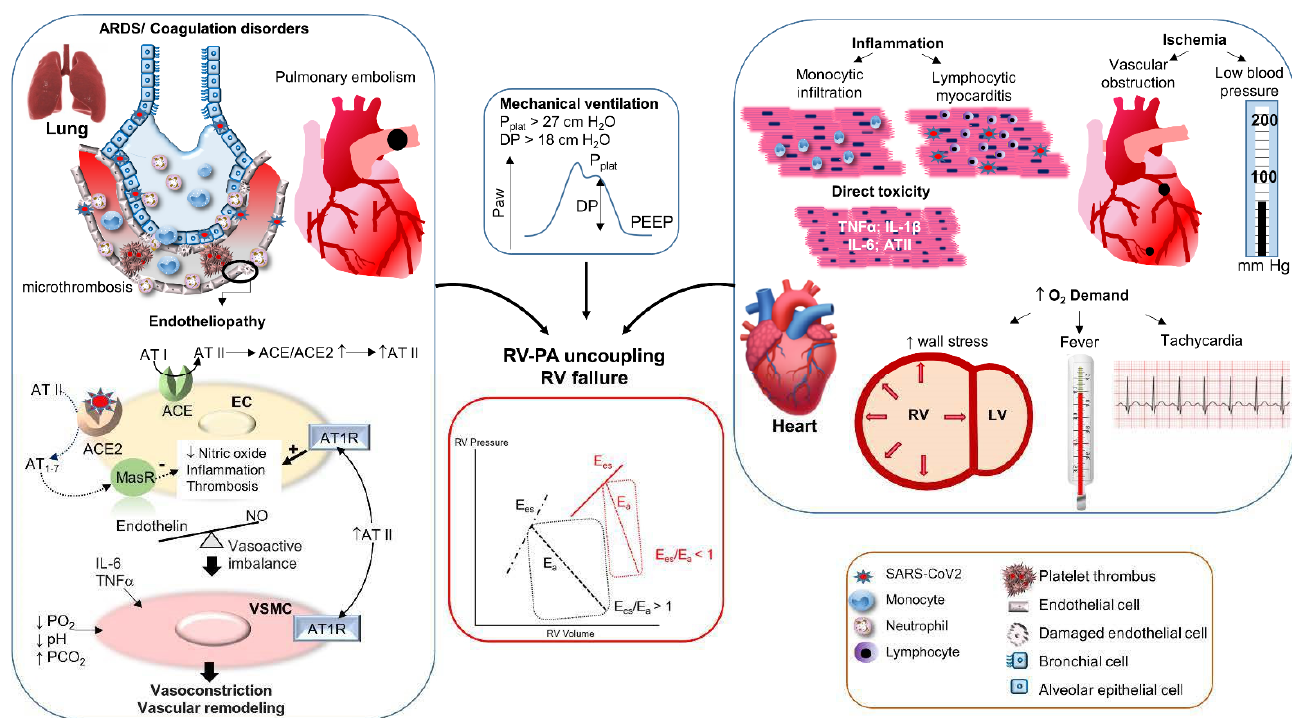
Figure 2. Pathophysiological mechanisms of RV dysfunction in COVID-19 ARDS. Upper left panel: Viral infection of lung epithelial cells triggers an intense inflammatory response, promoting the recruitment of inflammatory monocytes and neutrophils, as well as the upregulation of an array of inflammatory cytokines, resulting in endothelial damage and dysfunction, commonly defined as endotheliopathy. Lower left panel: The endotheliopathy is further aggravated by ACE/ACE2 imbalance following ACE2 degradation in endothelial cells (EC) in response to SARS-CoV2 receptor ligation. In turn, ACE2-dependent metabolism of angiotensin II (AT II) into Angiotensin 1-7 (AT 1-7 ) is reduced, with decreased signaling through the Mas Receptor (MasR), which normally conveys anti-inflammatory, vasodilatory (NO-dependent), and antithrombotic effects, and increased AT II signaling through the AT II receptor type 1 (AT1R). The latter promotes prothrombotic and pro-inflammatory effects, favoring diffuse pulmonary intravascular coagulation, with both micro and macrothromboses (pulmonary embolism), as well as vasoactive imbalance leading to sustained vasoconstriction. In addition, direct actions on vascular smooth muscle cells (VSMC) of AT II, cytokines (IL-6, TNF α ), hypoxia, and hypercapnic acidosis amplify vasoconstriction. Middle upper panel: In patients requiring mechanical ventilation, too high plateau pressure (P plat > 27 cm H 2 O) and driving pressure (DP > 18 cm H 2 O) may compress alveolar vessels. The overall resulting effects of these processes is an increase in pulmonary vascular resistance, which increases the pulmonary vascular hydraulic load. Right panel: COVID-19 may be complicated by myocardial inflammation due to direct viral infection (lymphocytic myocarditis, rare) or, more often, to a monocytic type of inflammation in the setting of systemic inflammation. Myocardial damage and reduced contractility may be further enhanced by the direct actions on cardiomyocytes of cytokines (TNF α , IL-1 β , IL-6) and AT II, as well as by ischemic complications resulting from macro- or microvascular thromboses and systemic hypotension, which may be further aggravated in conditions of increased myocardial oxygen demand induced by fever, tachycardia, and increased wall stress (RV dilation). Inflammation and necrosis of cardiomyocytes, in turn, result in a decrease of RV contractility. Middle lower panel: The concomitant increase in pulmonary vascular hydraulic load (increased arterial elastance, Ea) and reduction in RV contractility (decreased RV end-systolic elastance, Ees) precipitate RV-PA uncoupling (Ees/Ea < 1), leading to RV dilation and acute RV failure (red-colored pressure-volume RV